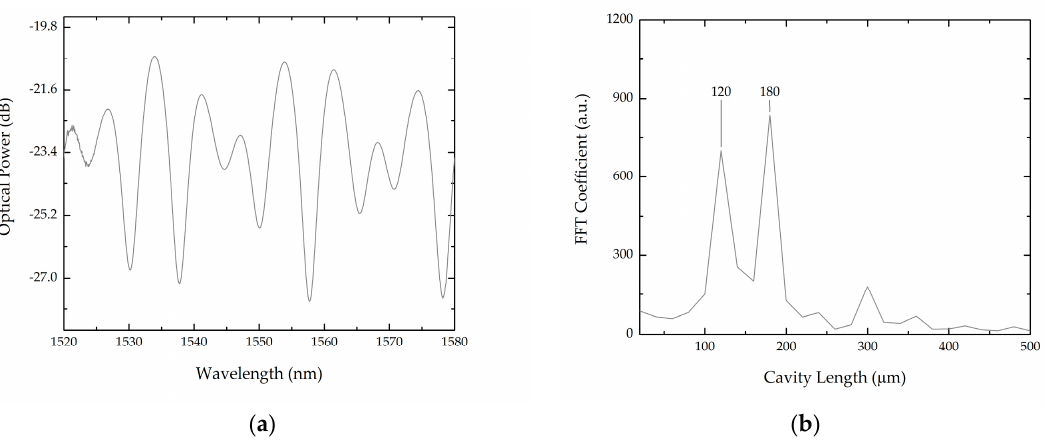
Figure 3. ( a ) Reflected spectrum of the fabricated hollow microsphere and ( b ) corresponding FFT.